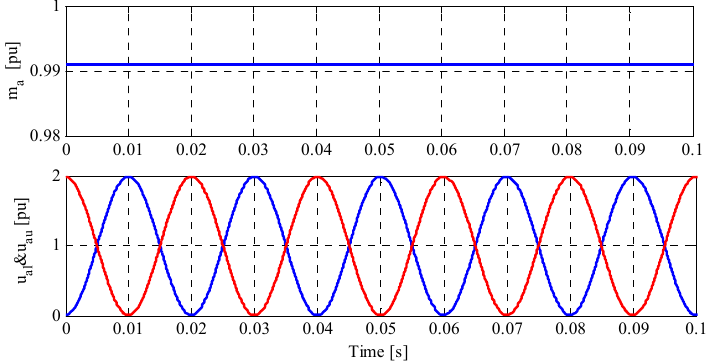
Figure 3. The proposed modulation index and function as to parameters given in Table 1.